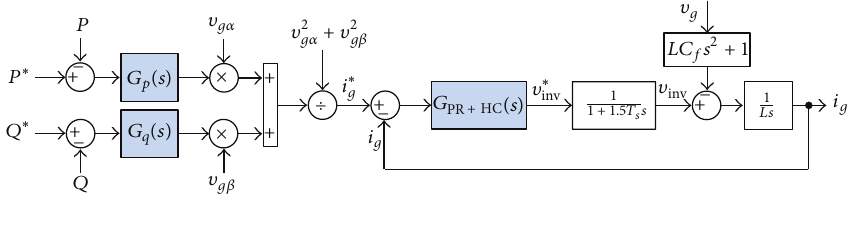
Figure 10: Control diagram of a single-phase grid-connected system with PR controller and harmonic compensators based on single-phase 𝑃𝑄 theory.